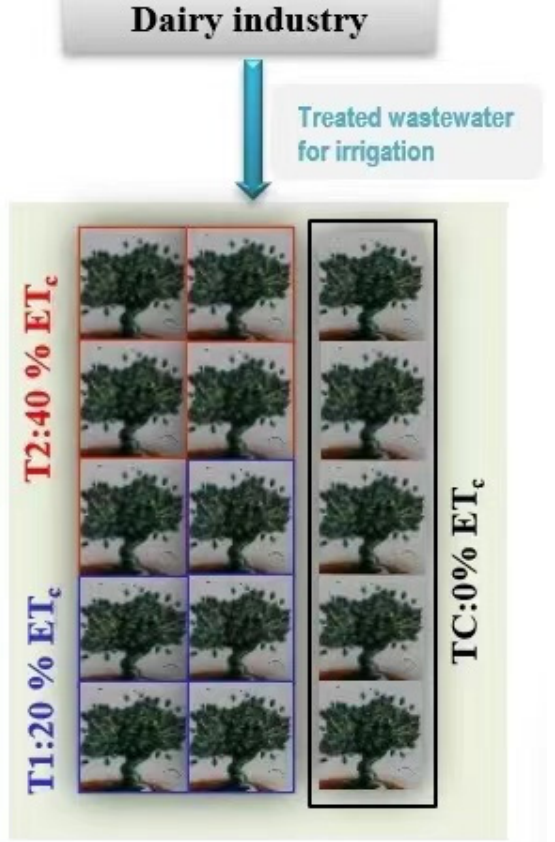
Figure 1. Experimental design